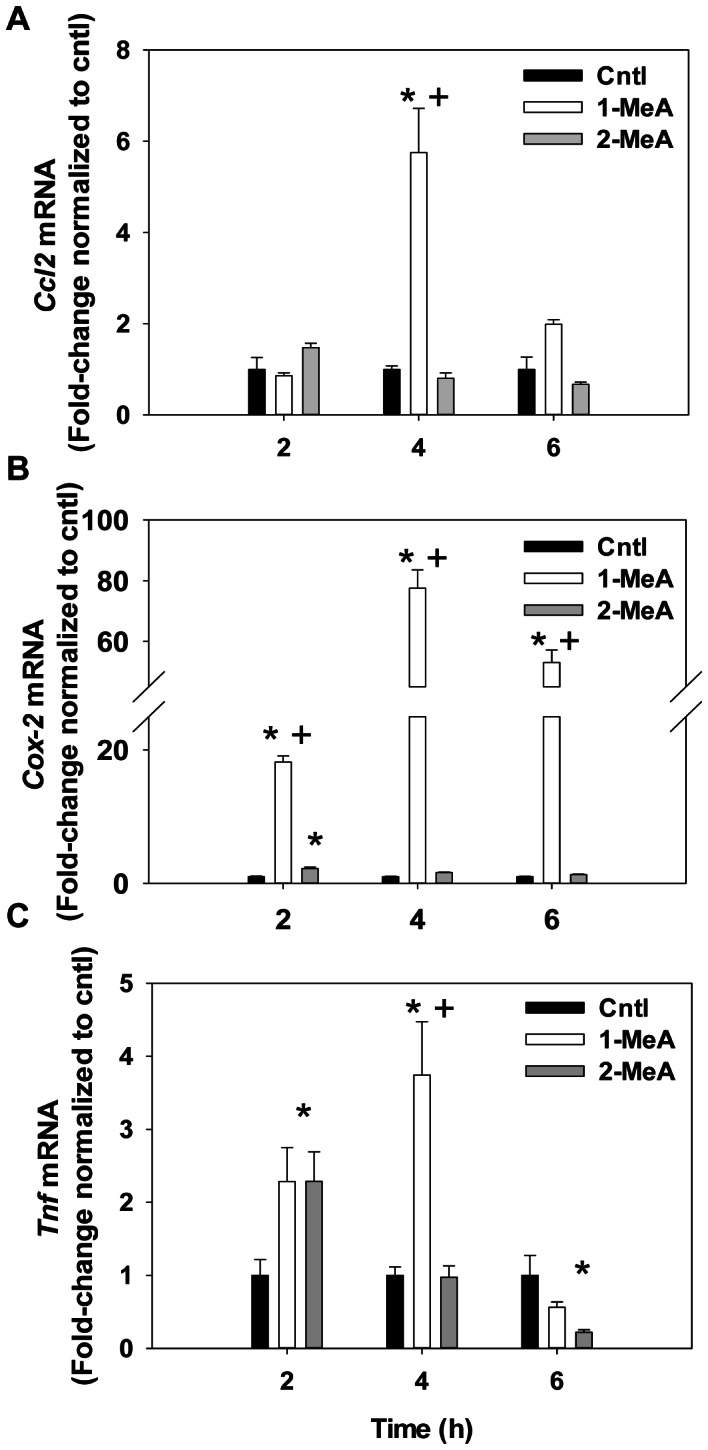
Inflammatory pathways downstream of MAPKs and dysregulation of GJIC are influenced by 1-MeA.(A) Ccl2, or Mcp-1, mRNA expression in response to 1-MeA, 2-MeA, or control treated cells. (B) Ptgs2, or Cox2, mRNA expression in response to 1-MeA, 2-MeA, or control treated cells. (C) Tnf mRNA expression in response to 1-MeA, 2-MeA, or control treated cells. Concentrations used: 1-MeA, (75 µM) and 2-MeA (75 µM). For each gene, mean and SEM are presented; n = 3 per treatment, repeated twice. Genes are first normalized to 18S followed by normalization to acetonitrile control per time point. Cntl = control acetonitrile; 1-MeA, 1-methylanthracene; 2-MeA, 2-methlyanthracene; Ccl2, chemokine (CC-motif) ligand 2; Mcp-1, monocyte chemoattractant 2; Cox-2, cyclooxygenase 1; Ptgs2, prostaglandin-endoperoxide synthase 2; Tnf, tumor necrosis factor α.